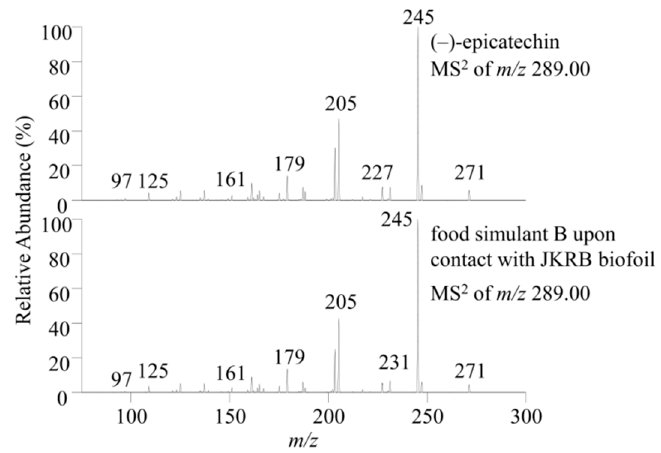
Figure 6. Comparison of MS 2 spectra of ( − )-epicatechin standard and the target compound in the sample (a leachable of JKRB biofoil into food simulant B (3% acetic acid (aq) ) is given as an example). ( − ) ‐ Epicatechin was identified in all food simulants based on t r , MS, and MS 2 spectra. The LC ‐ MS method for the quanti fi cation of ( − ) ‐ epicatechin in food simulants was validated for the following parameters: range, linearity, LOD, LOQ, repeatability, accu ‐ racy, and precision. The concentration range was from 0.25 to 25.00 μ g mL –1 , R 2 was 0.9998,